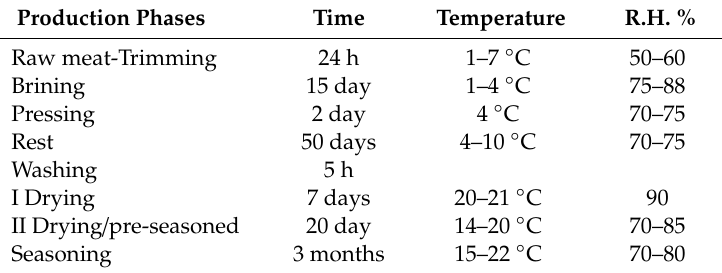
Table 1. Flowchart of dry cured ham